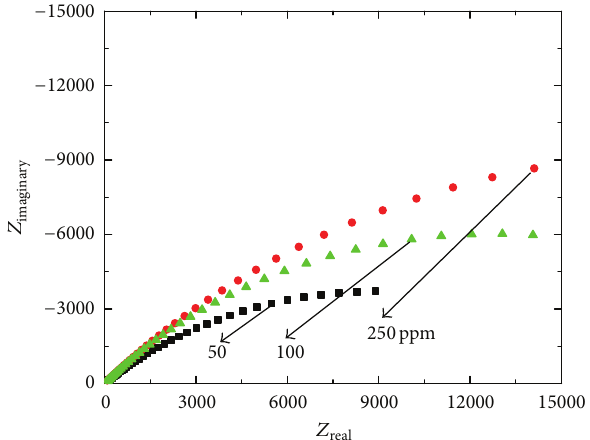
Figure 7: Nyquist diagram for carbon steel in 1M HCl containing 50 ppm concentration of inhibitor showing experimental and fitting